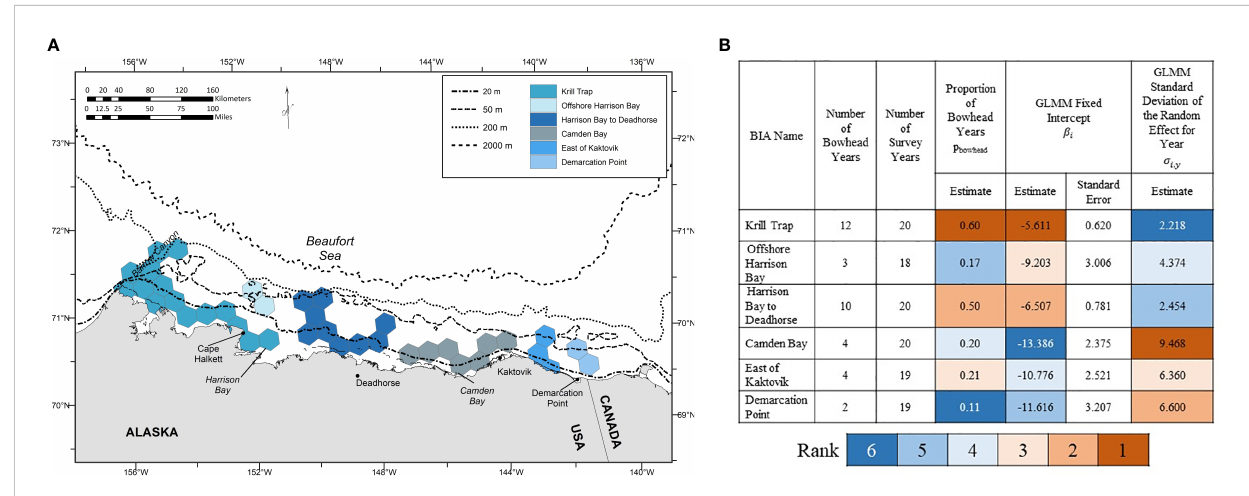
FIGURE 4 Results of the inter-annual variability analysis for each of the six Biologically Important Areas (BIAs) identi fi ed in the selected scenario for feeding/ milling bowhead whales in September. (A) Geographic location. (B) Summary statistics and GLMM parameter estimates. Parameter estimates are color-coded based on their associated rank, from high (rank 1) to low (rank 6).